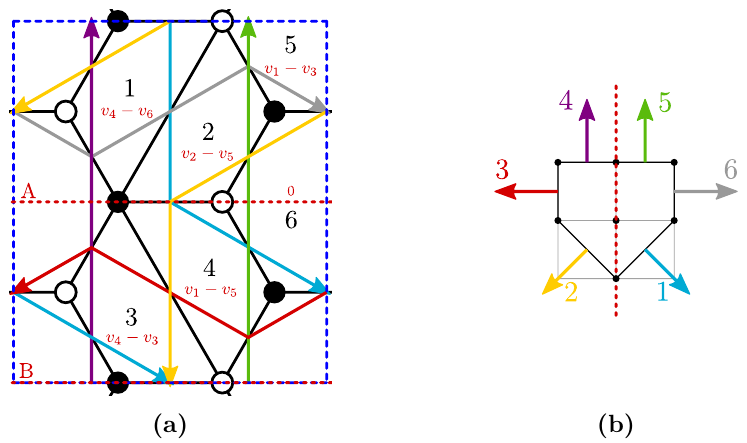
Figure 11. (a) Dimer diagram for PdP 3 b with two horizontal fixed lines (dotted red). We show the ZZPs and the rank assignments coming from them. (b) The toric/web diagram with the corresponding symmetry